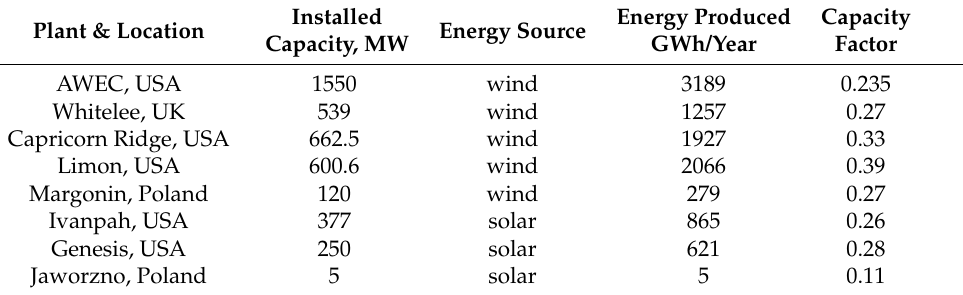
Table 1. Capacity factor of selected wind and solar power plants. Plant & Location